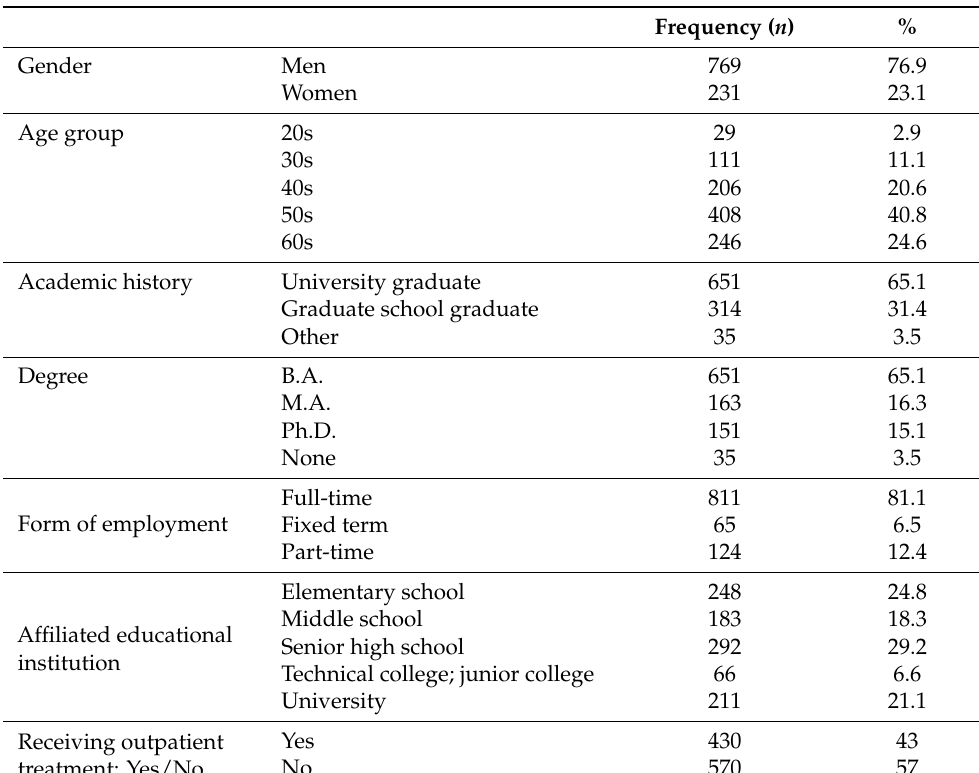
Table 1. Participants’ sociodemographic